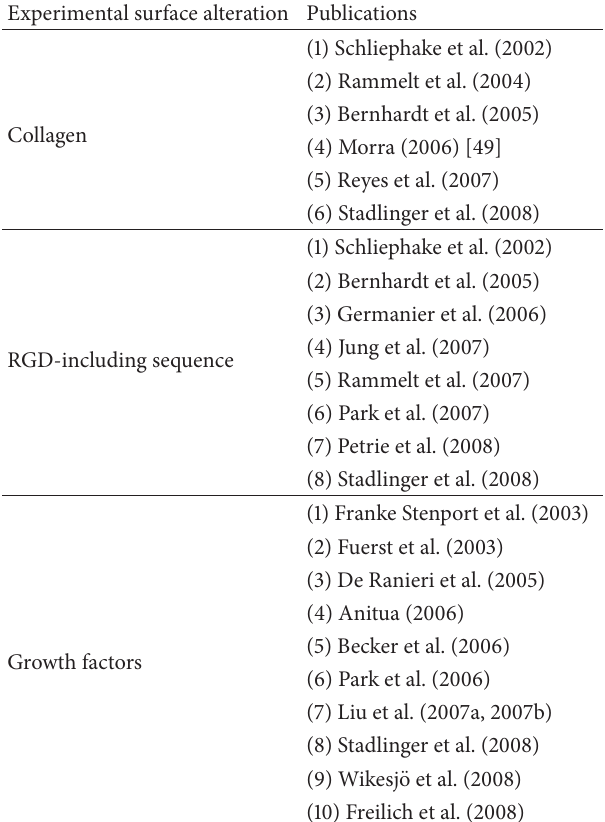
Table 4: Experimental surface alteration